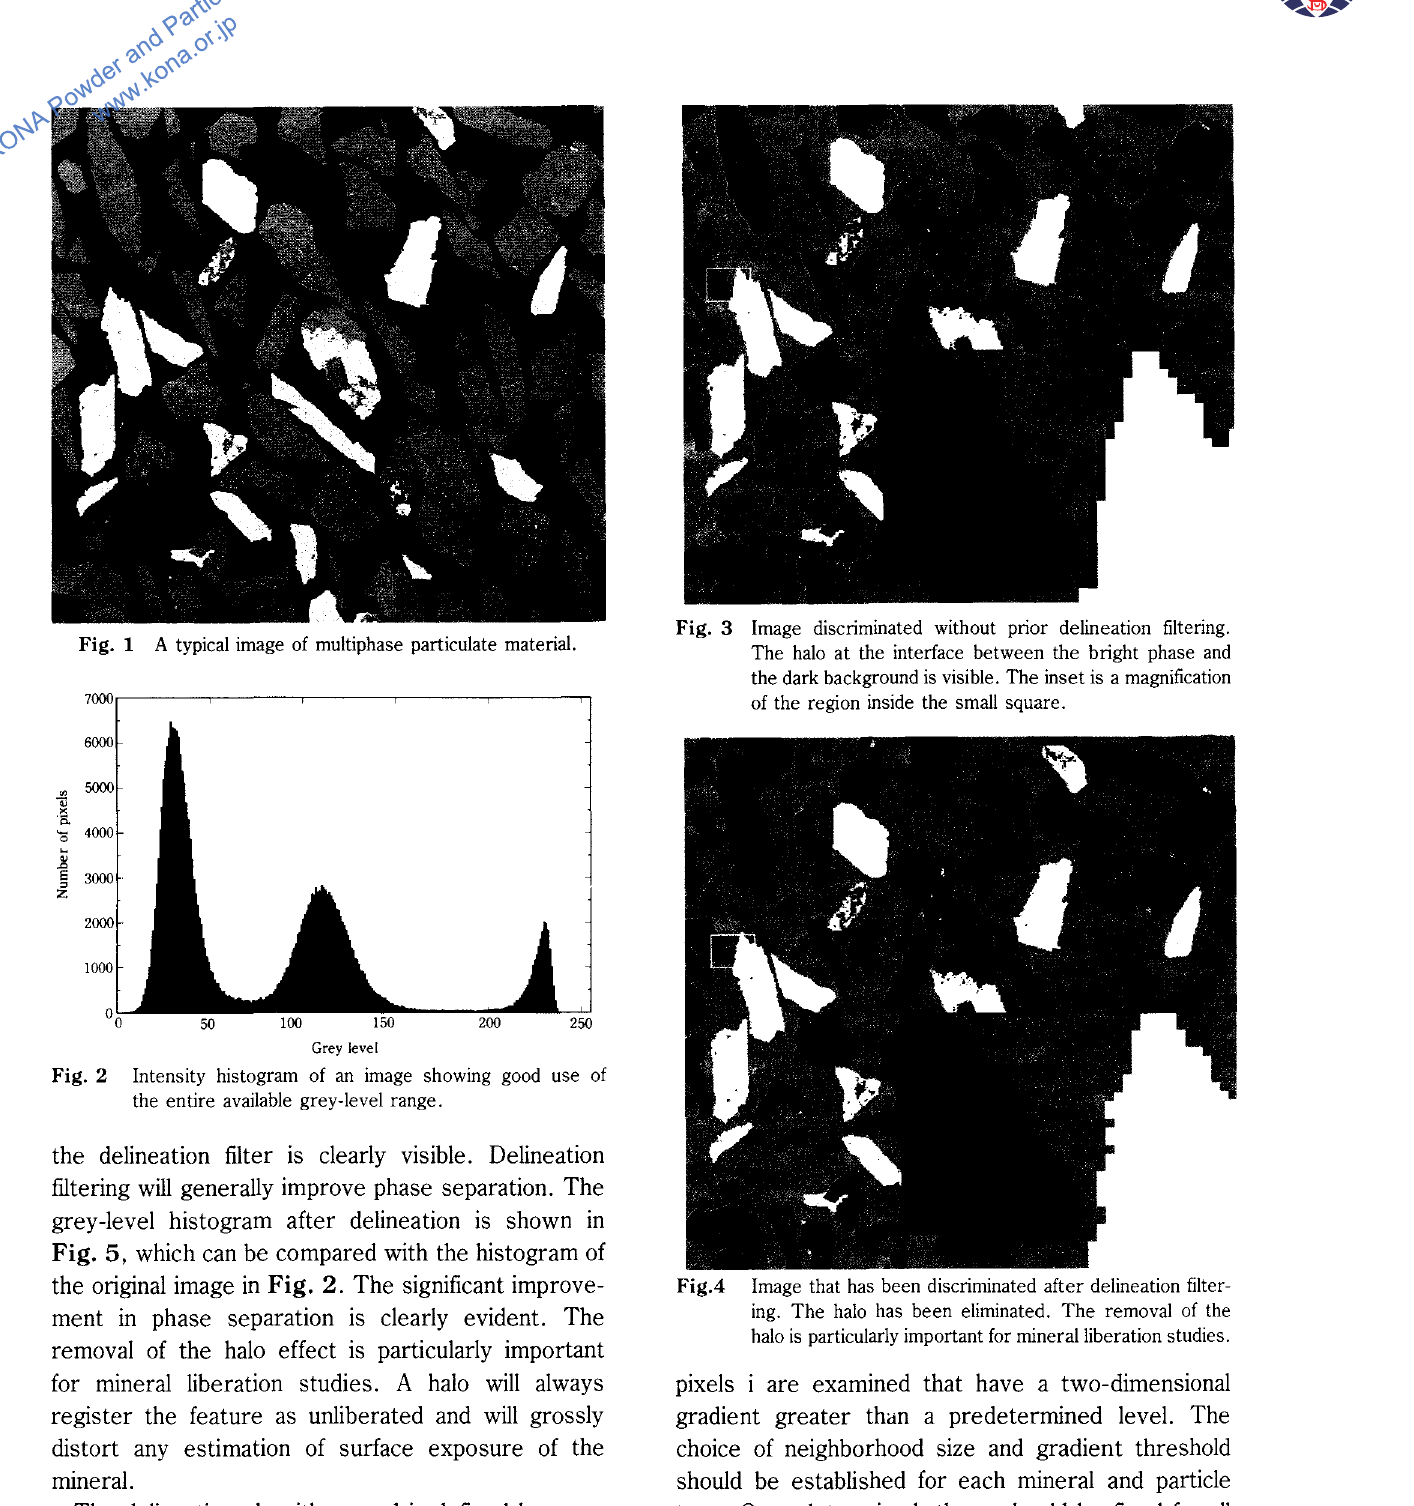
Image that has been discriminated after delineation filter ing. The halo has been eliminated. The removal of the halo is particularly important for mineral liberation